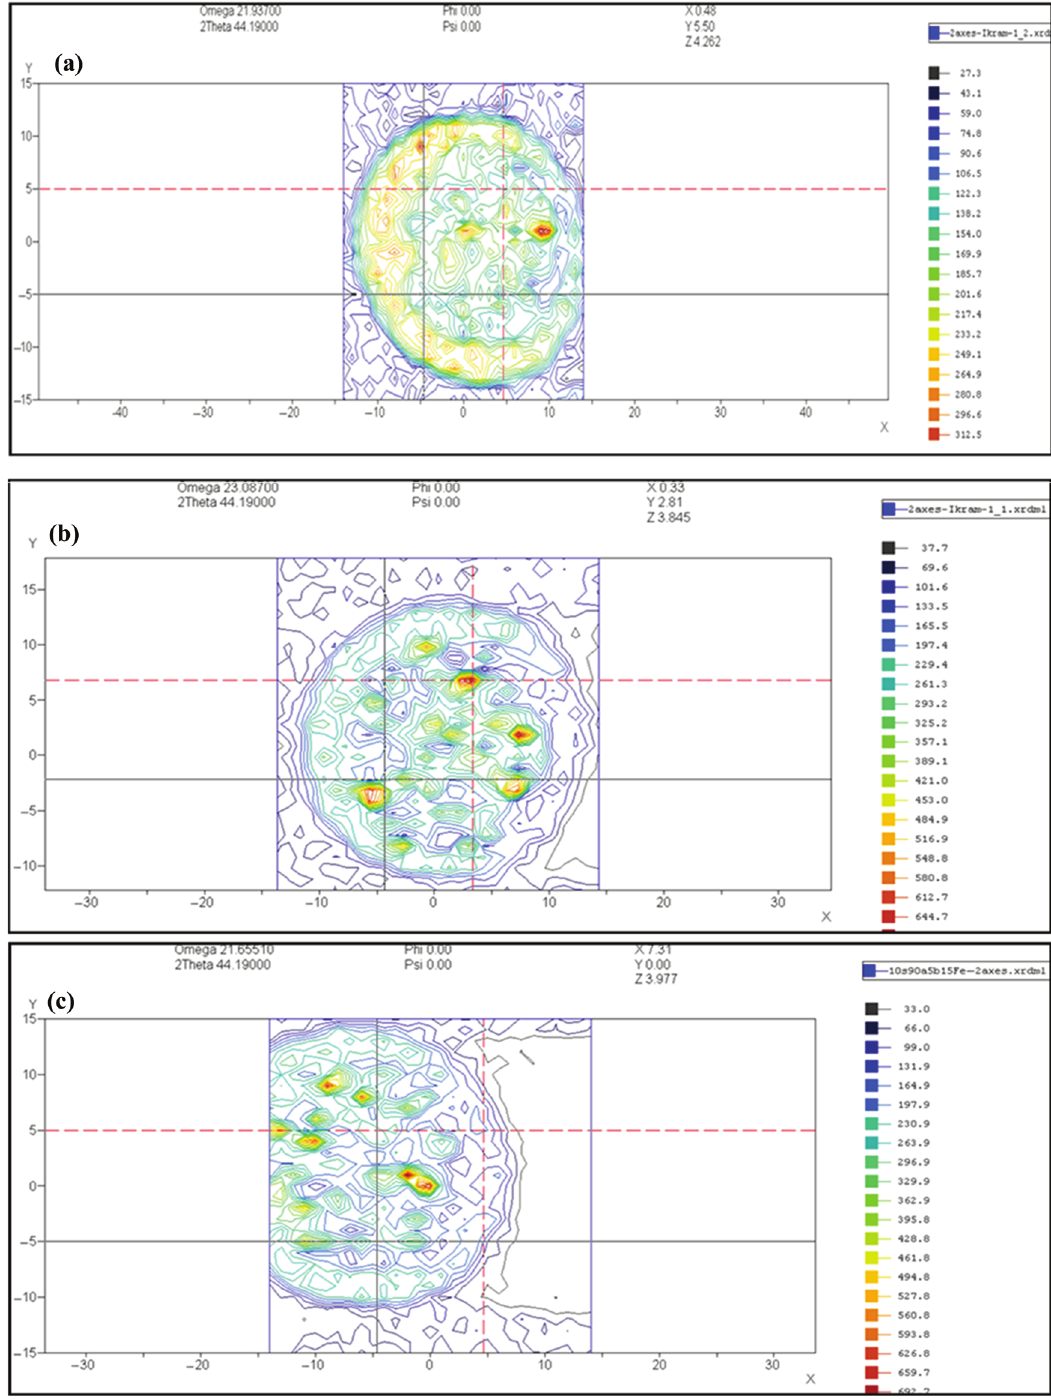
Figure 7: Epitaxial mapping of reacted pellets at 44.19° for locating the position of Fe 3 Al reaction product [(a) AS1 – 5Fe, (b) AS1 – 10Fe and (c) AS1 –